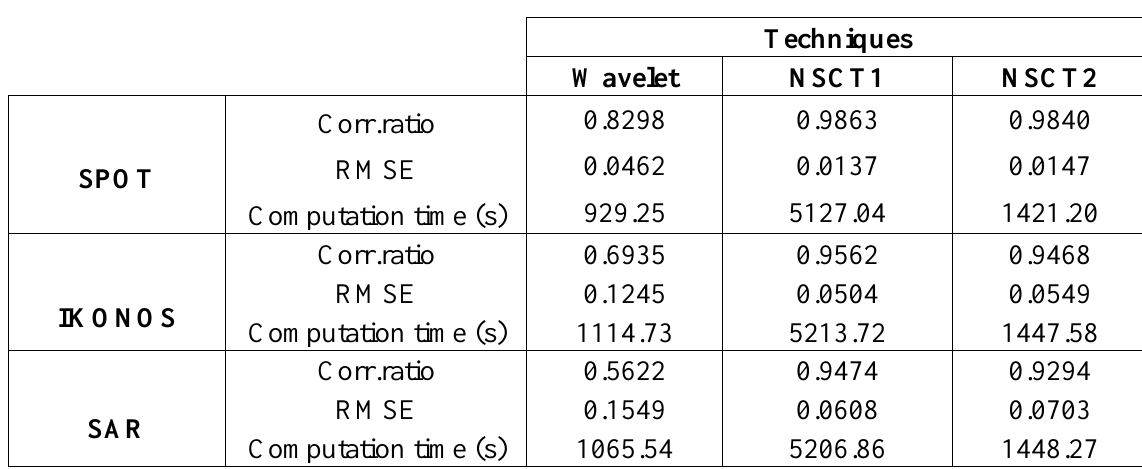
Table 1. Analytical results for the three registration